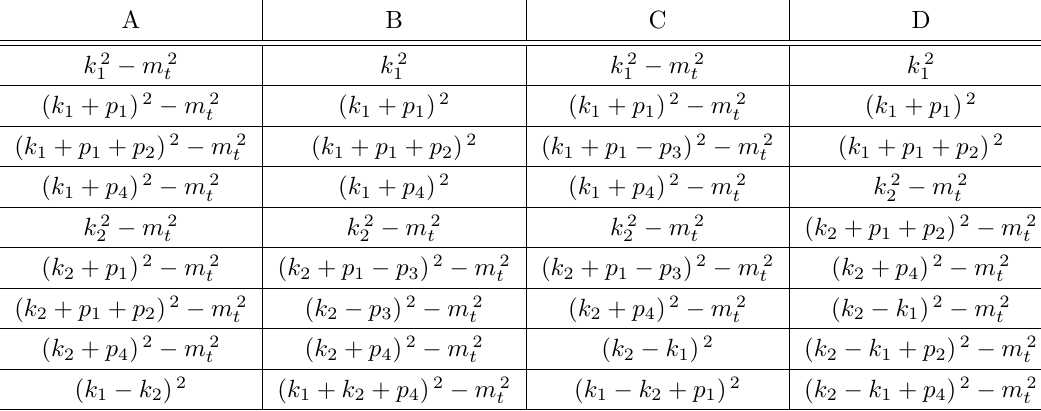
Table 1. List of integral families and their